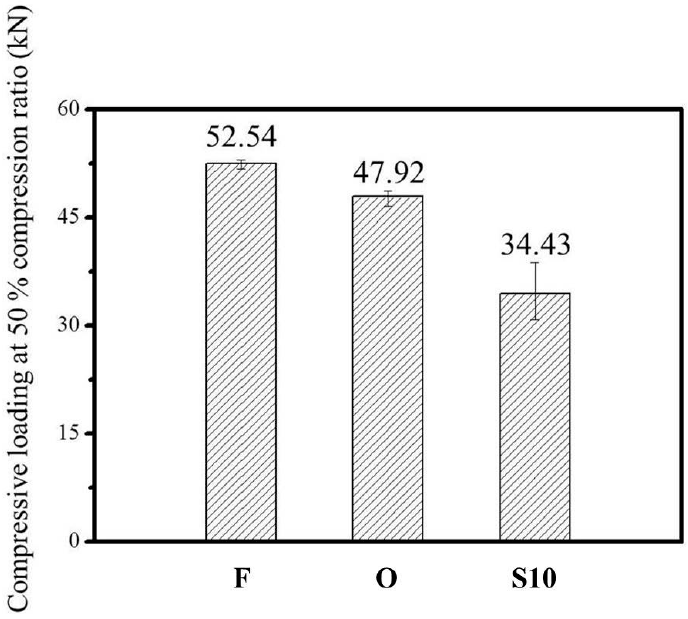
Figure 7. Deformation resistance of several materials.